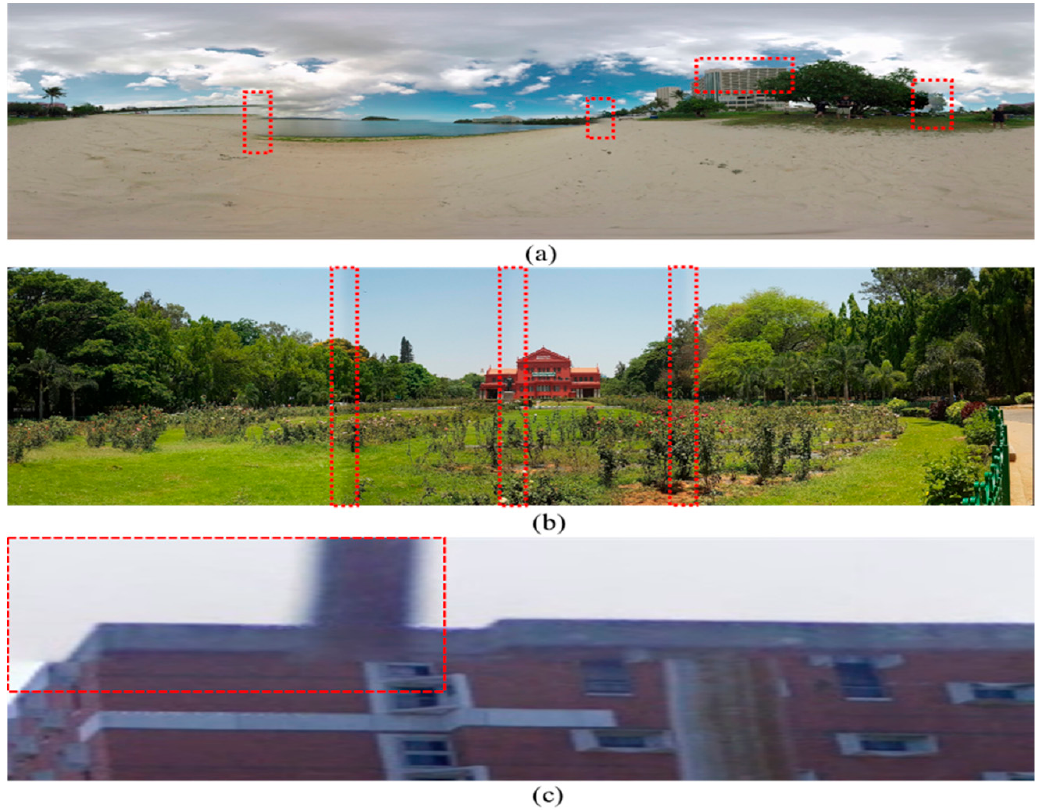
Figure 1. Illustration of various stitching errors: ( a ) Parallax error, ( b ) blending error, and ( c ) blur error.